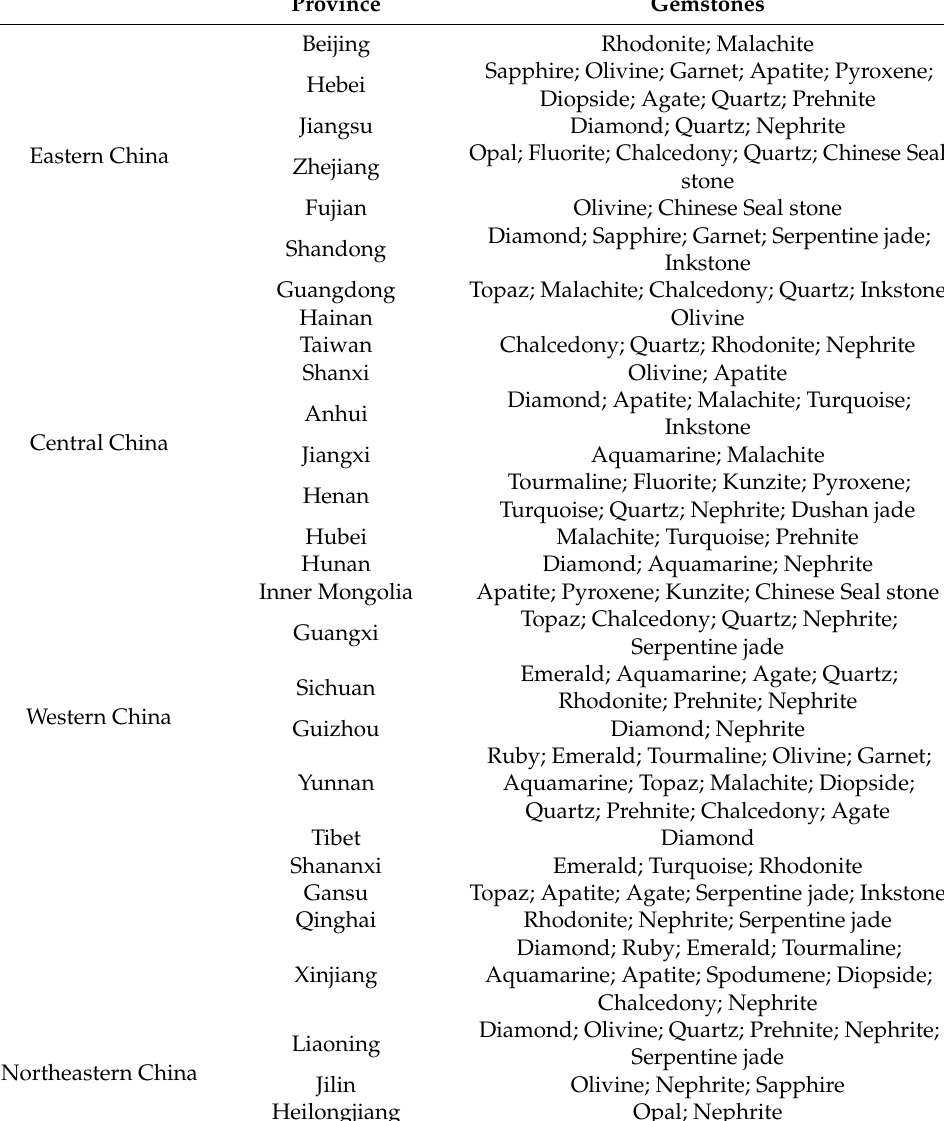
Table 1. The distribution statistics of Chinese gemstones in each